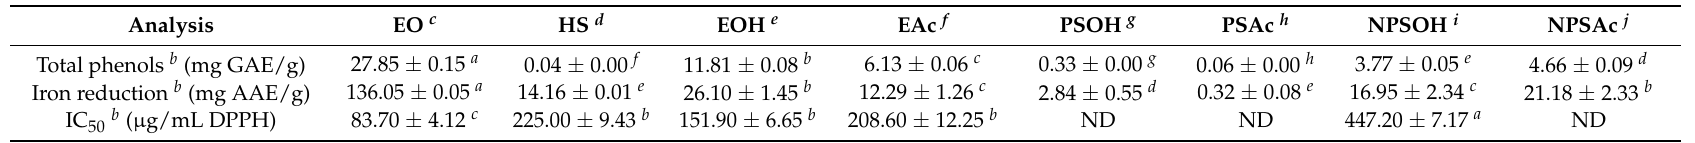
Table 2. Total phenols quantification and antioxidant activity of P. longiflora Mexican oregano essential oil, hydrosol and extracts from waste solid residues a .